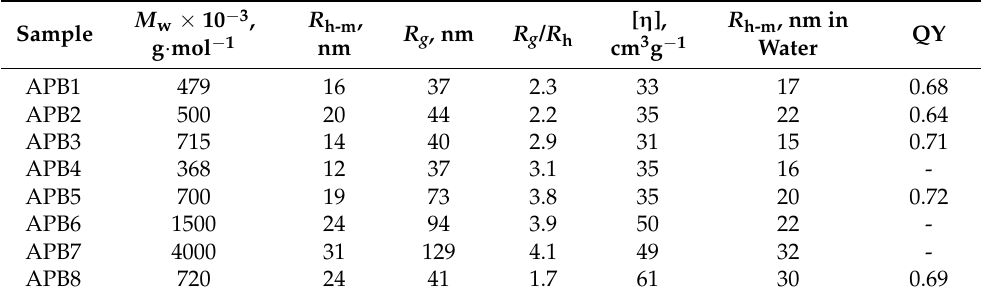
Table 4. Molar masses, hydrodynamic characteristics, and quantum yields of